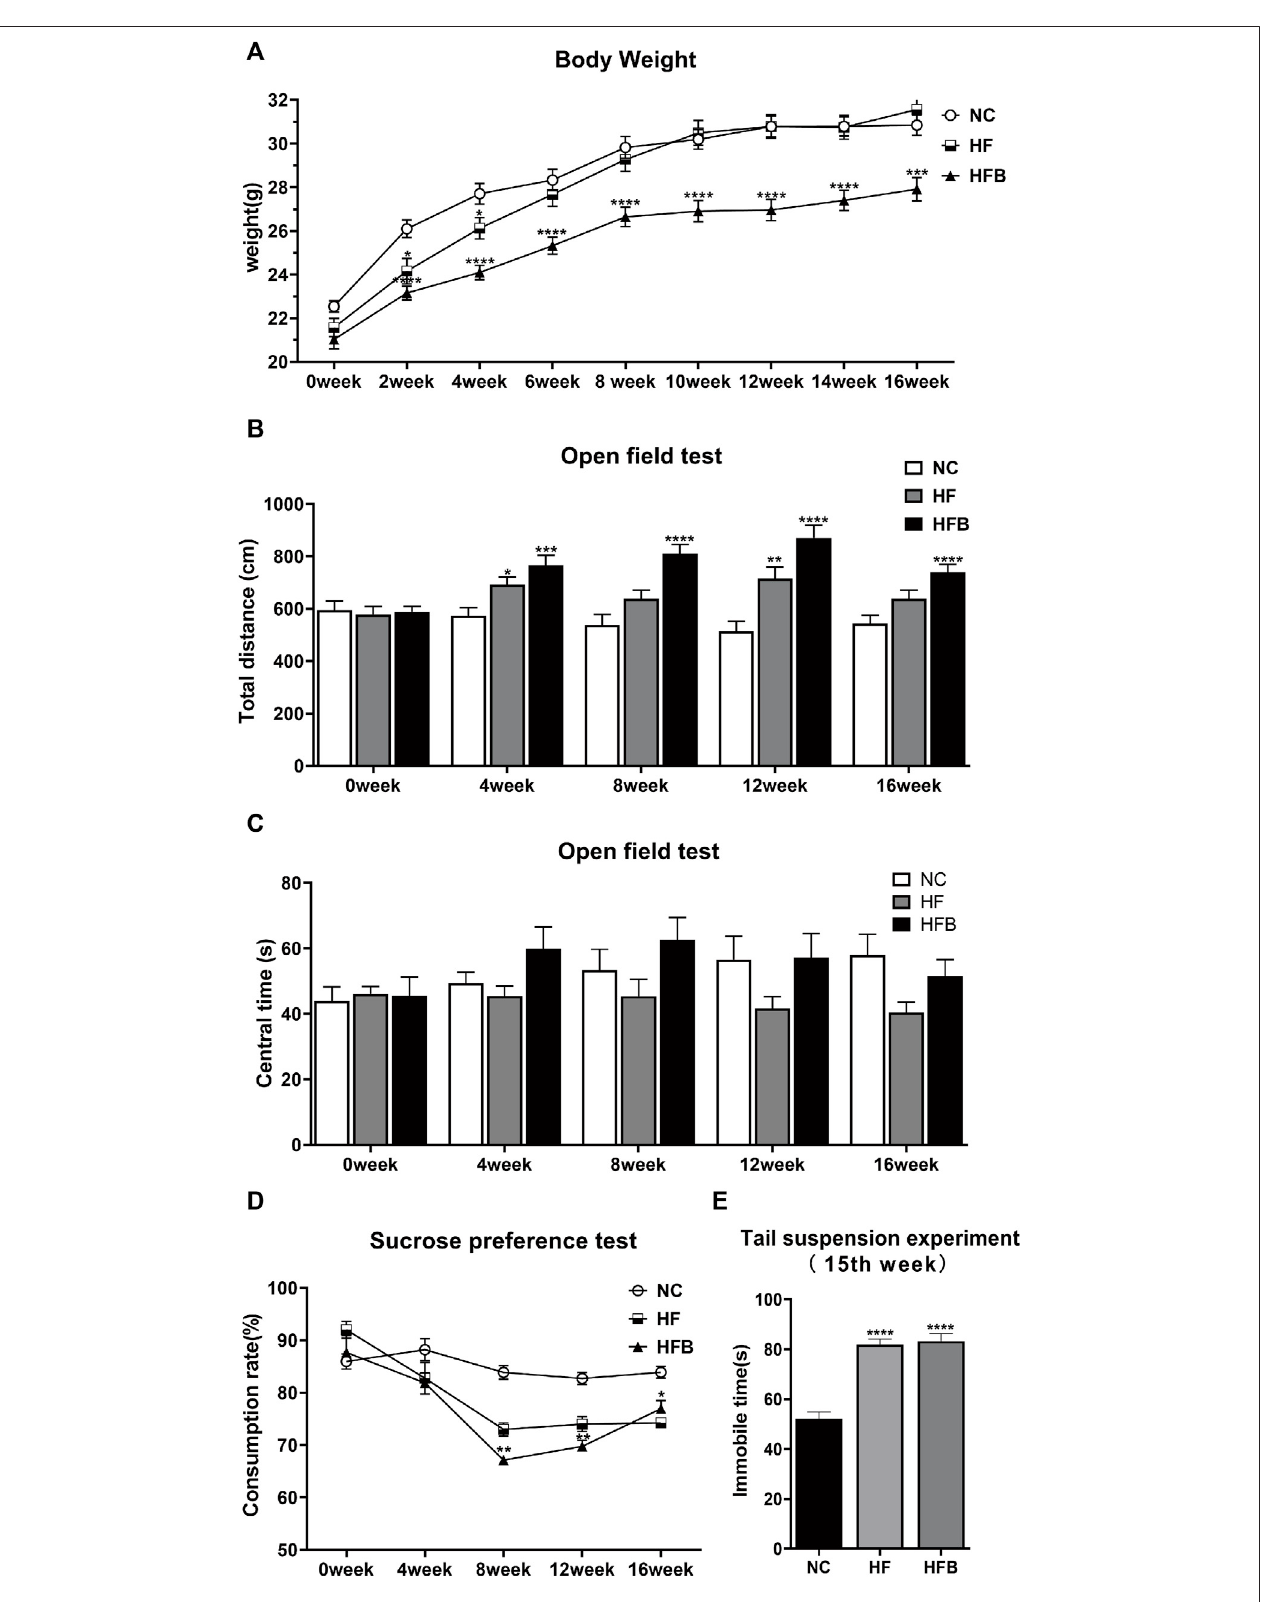
FIGURE 1 | Behavioral changes in ApoE − / − mice fed continuous high-fat combined with bound stimulation. (A) Measurement of body weight. (B) Total distance traveled in the open- fi eld test. (C) The overall duration of stay in the central area of the open- fi eld test. (D) Sucrose preference test. (E) Immobility time of the tail suspension experiment. n = 14, mean ± SEM. *, p < 0.05; **, p < 0.01; ***, p < 0.005; ****, p < 0.001; vs. NC.